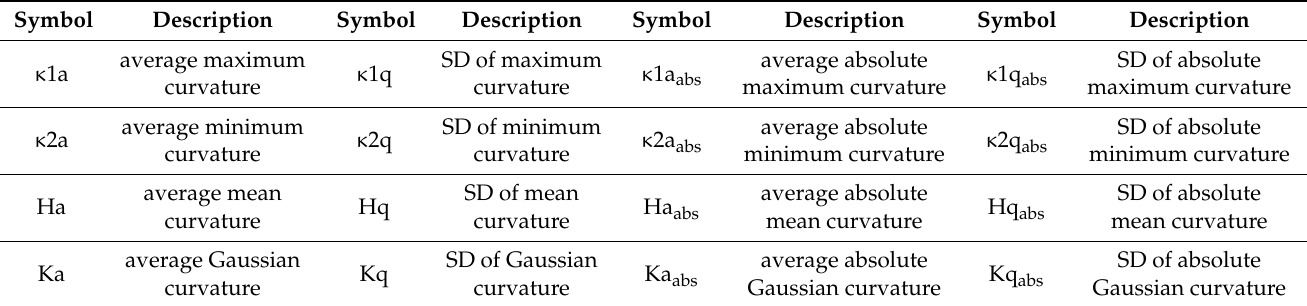
Table 3. Curvature statistical parameters used in the study. Please note that SD stands for standard deviation.